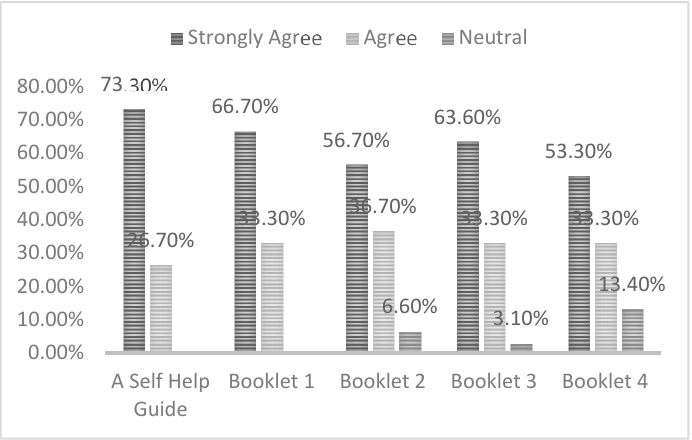
Figure 3. Supplementary materials coverage.